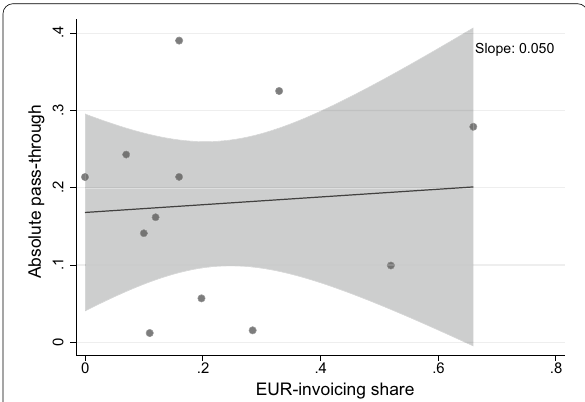
Fig. 7 EUR-invoicing share and pass-through across retail HICP categories. Notes: Linear regression of the synthetic pass-through estimates on the EUR-invoicing share for HICP retails goods only. The slope of the regression lines is shown in the charts. EUR-invoicing share data are retrieved from Auer et al. (2021). Pass-through is taken in absolute value due to a few negative values. Bands show the 95% confidence interval of the regressions